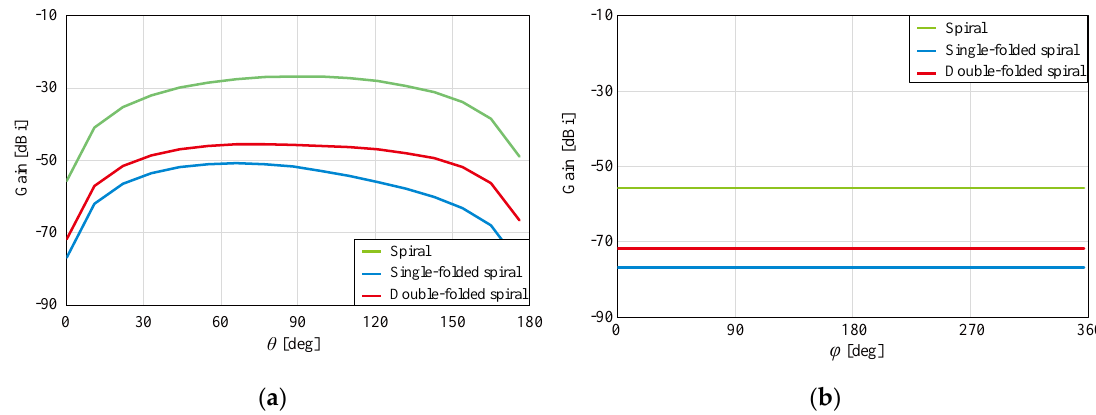
Figure 8. Q factor and coupling coefficient k : ( a ) Q factor, ( b ) Coupling coefficient k.